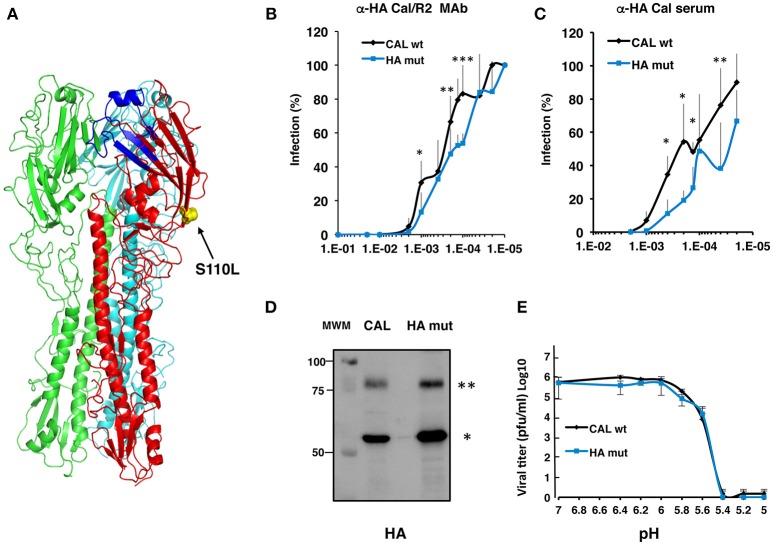
Characterization of HA from CAL and HA mut viruses. (A) Structure of HA trimer in Protein Data Bank (PDB) under accession 3AL4 has been used as template for structural localization of HA 110L (yellow) mutation with UCSF Chimera 1.10.2. (B) Neutralization assays of MDCK cells infected with Cal and HA mut viruses using serial dilutions of monoclonal antibody α-HA/Cal/2. Significance was determined by two-way ANOVA with Bonferroni post-hoc test (*p < 0.05; **p < 0.01; ***p < 0.001). (C) Neutralization assays on MDCK cells infected with CAL and HA mut viruses using serial dilutions of a polyclonal antibody raised against HA from A/California/07/09. The viral infectivity is shown as a percentage of each virus infection in the absence of antibody. The experiments were performed twice and in duplicate using six different viral doses. Significance was determined by two-way ANOVA with Bonferroni post-hoc test, **p < 0.01. (D) Movility of HA. CAL or HA mut viruses were applied to SDS-gels, followed by Western bot assays using α-HA/Cal/2 monoclonal antibody. (**) denotes HA0, and (*) HA1. (E) pH stability of HA. CAL and HA mut viruses were incubated at the indicated pHs and their replication capacity evaluated in MDCK cells by plaque assay. The experiment was performed in triplicates and each plaque assay was performed twice. Significance was determined by two-way ANOVA with Bonferroni post-hoc test, ns (not significant).